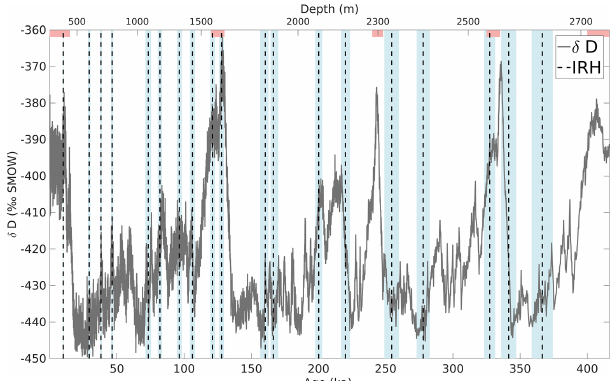
Figure 5. Temporal coverage of the dated IRHs (as dashed black vertical lines) over the past four glacial cycles, here displayed on top of δD variations in per mil Standard Mean Ocean Water (SMOW) measured on the EDC ice core and using the AICC2012 chronol- ogy (Bazin et al., 2013). IRH age uncertainties are indicated by light blue shading. Red bars highlight the interglacial periods for